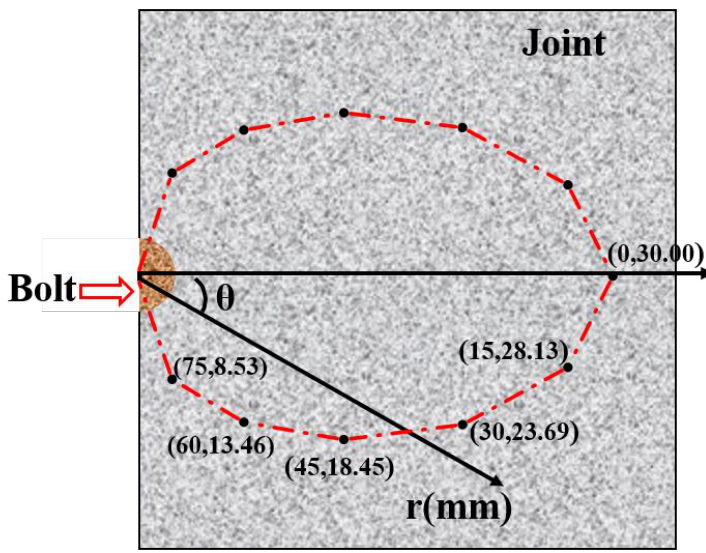
Figure 6. Action range diagram of bolt under theoretical deduction.